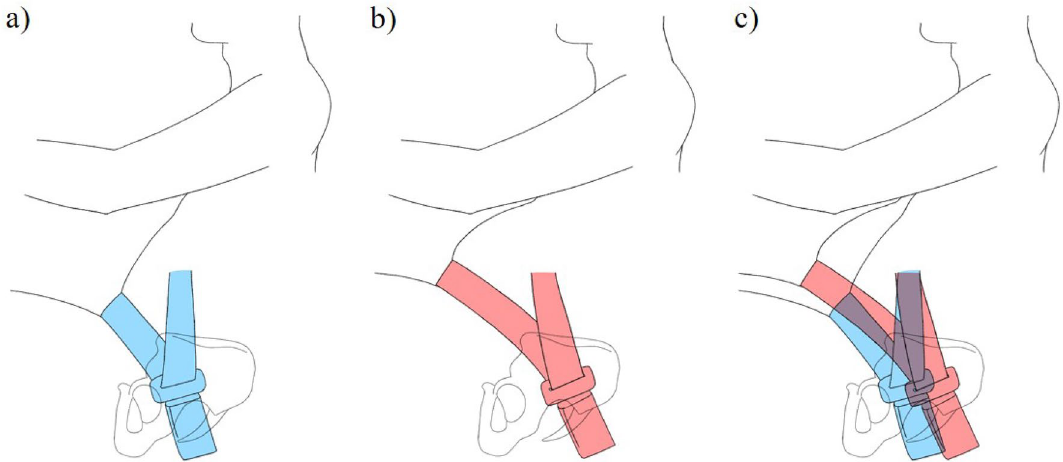
Figure 6. The relationship between the pelvis and seat belt position of a lower BMI occupant ( a ) and the pelvis and seat belt position of a higher BMI occupant ( b ) are shown. In comparison, the X and Z values are larger, and the lap belt angle is smaller for the higher BMI occupant ( c ). This may facilitate the submarine phenomenon where the pelvis goes under the lap